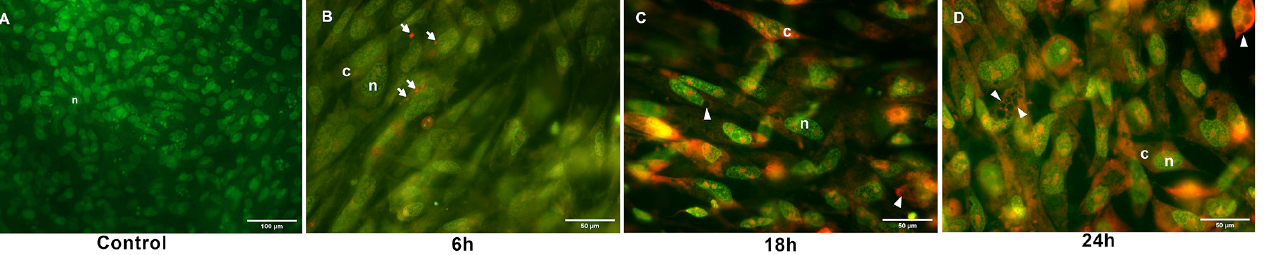
Figure 2. AO pattern changes inside CEF cells after ECVF treatment. (A) Control without ECVF, 24 hours. (B, C and D) CEF after ECVF incubation for 6, 18 and 24 hours, respectively. n: nucleus; c: cytoplasm. Arrows indicate lysosomes in orange and arrowheads indicate unstained vacuoles. Scale bars = 100 μm (A) ; 50 μm (B, C and D) .